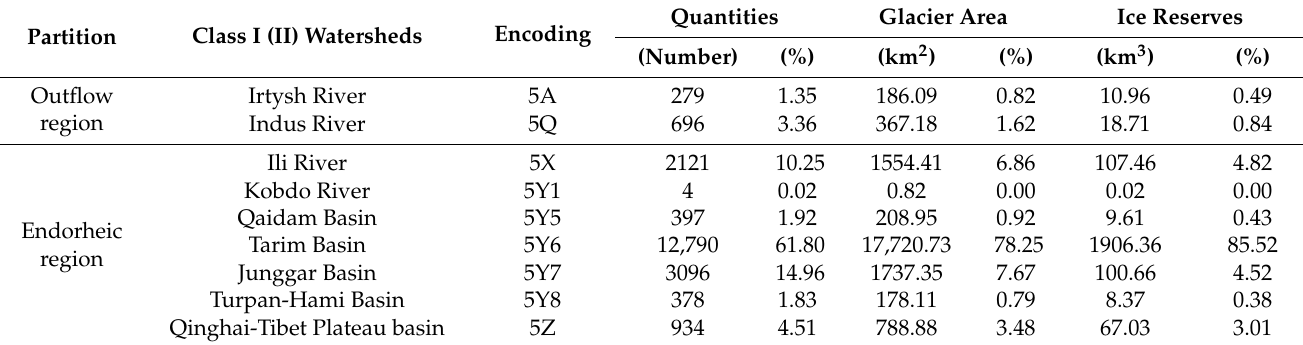
Table 3. The glacier resources in different watersheds in